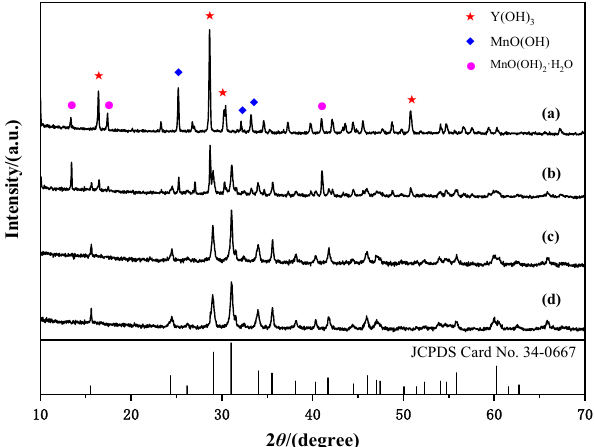
Figure 2. XRD patterns of products obtained by hydrothermal treatment at 180 °C at different oxidation times in the air: ( a ) 0 min; ( b ) 10 min; ( c ) 20 min; ( d ) 30 min.